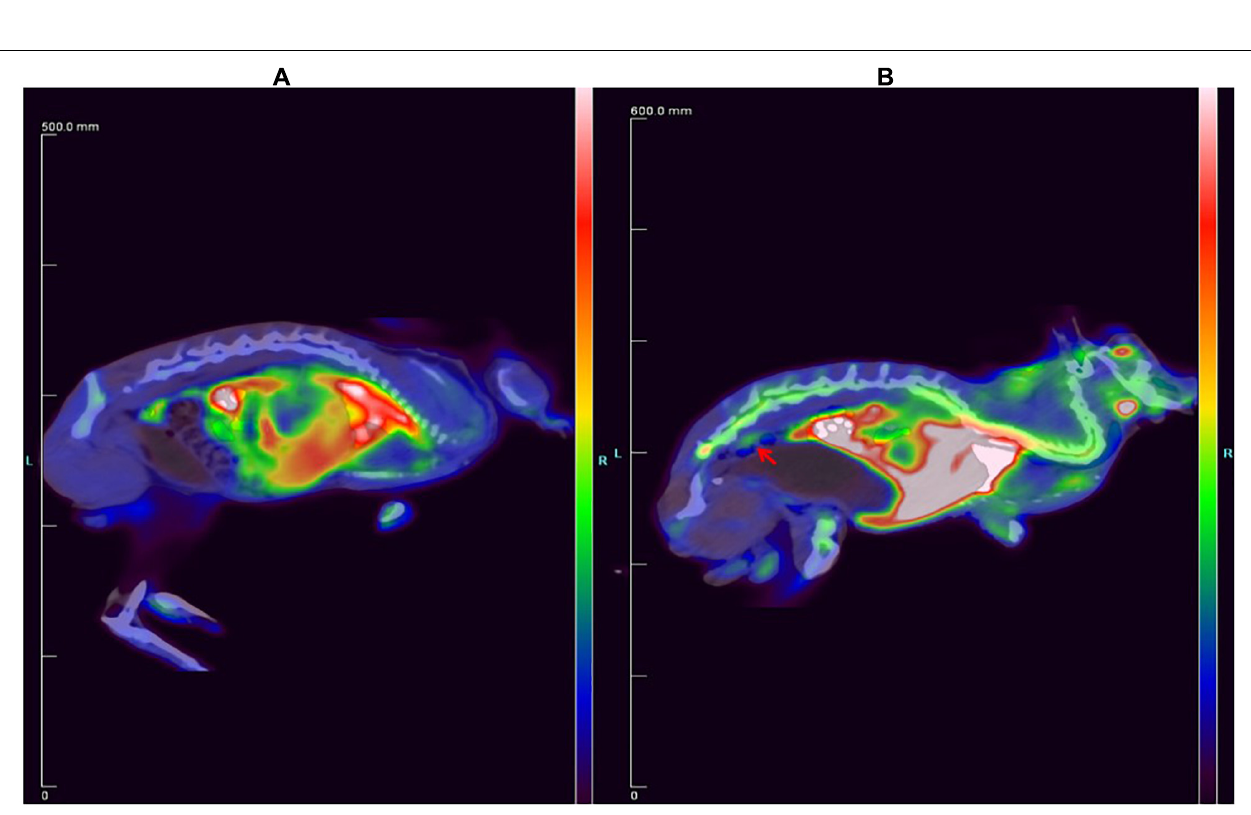
FIGURE 4 | Comparison of the New Zealand rabbit (A) treated with 18 F-FDG and (B) treated with 18 F-ASEM, in which the red arrow shows that 18 F-ASEM can recognize atherosclerotic plaques at the lower segment of abdominal aorta in the early stage.